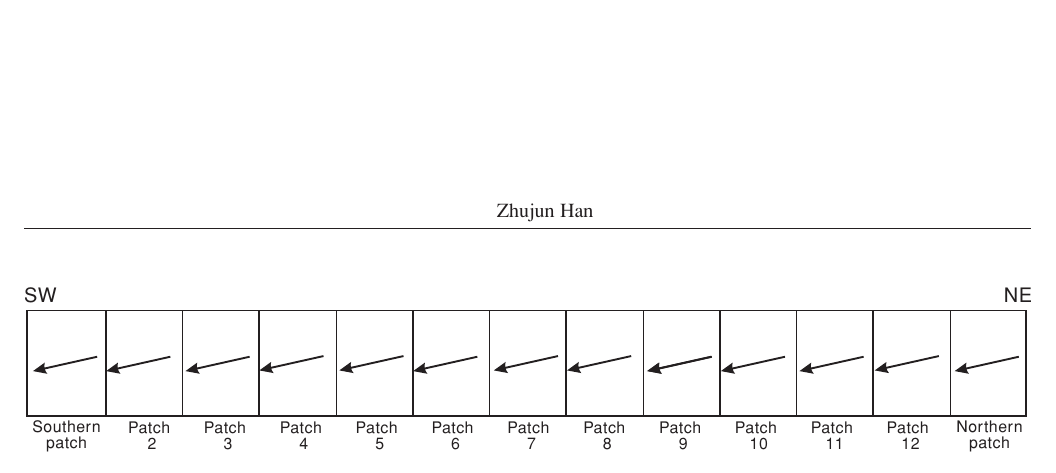
Fig. 4. The tapered-displacement Wairarapa Fault still has the listric shape and consists of five segment in the dip direction as shown in fig. 3, but each segment of the Wairarapa Fault is subdivided into 13 equal-sized, rec- tangular patches along the strike direction and the slip is linearly tapered from a maximum of 12 m horizontal displacement and 3 m vertical displacement at the center to 1.71 m and 0.43 m at the ends (table III). The arrow represents the rake direction.